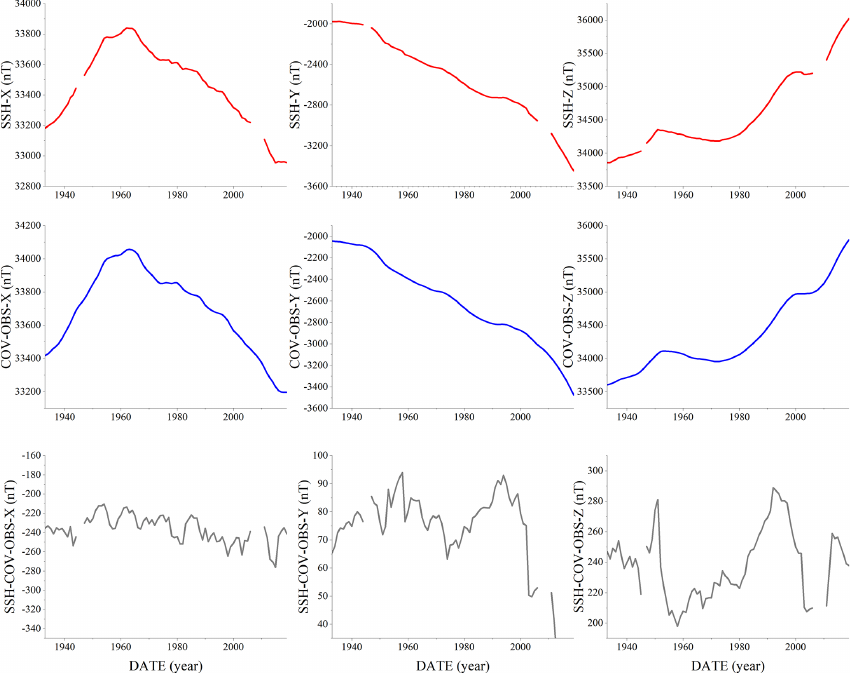
Figure 15. The AMV and their difference curves of X , Y , Z components calculated from the rescued records and the COV-OBS model.